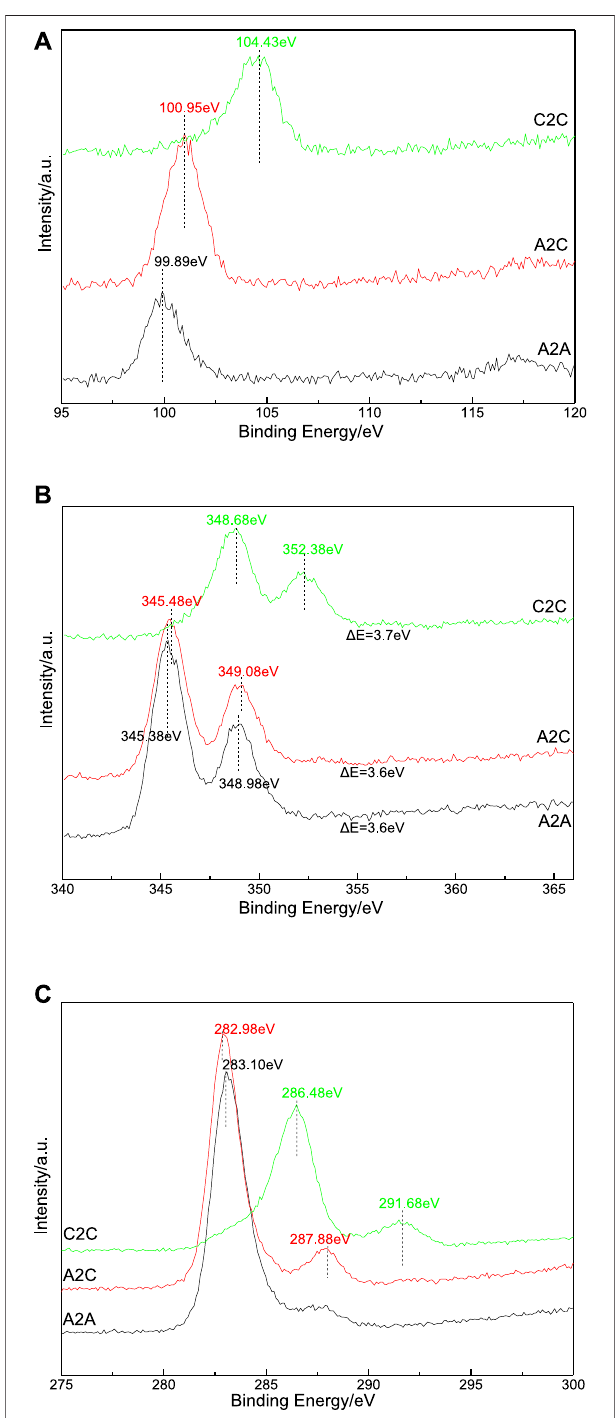
FIGURE 6 | Si 2p (A) , Ca 2p (B) and C 1s (C) XPS spectra of the uncarbonated areasampleinA2A-28d andcarbonatedareasamplesinA2C- 1d and